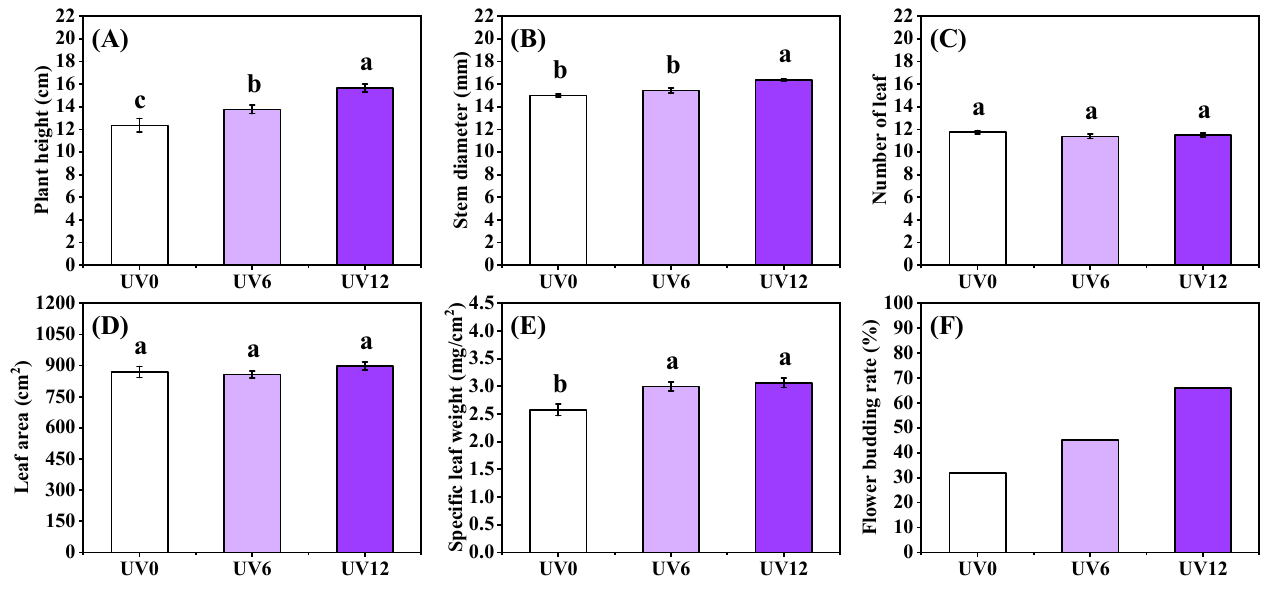
Figure 2. Morphology of Chinese kale exposed to different durations of UVA-radiation exposure. ( A ) Plant height (PH). ( B ) Stem diameter (SD). ( C ) Number of leaves (LN). ( D ) Leaf area (LA). ( E ) Specific leaf weight (SLW). ( F ) Flower budding rate. Different lowercase letters (a–c) labeled on the vertical bar (means standard error, n = 8) represent significant differences by one-way ANOVA ± with multiple-range tests ( p ≤